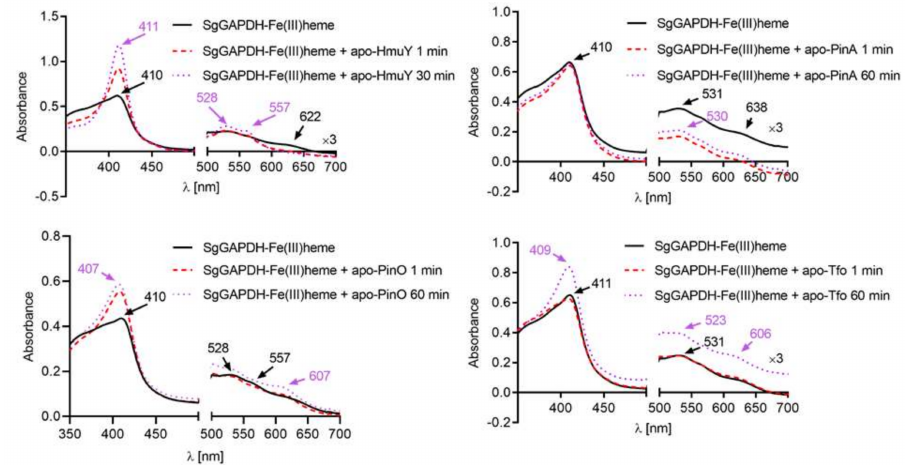
Figure 5. Heme sequestration by HmuY and its homologs from SgGAPDH-heme complex under oxidizing conditions. SgGAPDH-heme complex (10 µ M) was incubated under air (oxidizing) conditions with equimolar concentration of HmuY, PinO, PinA or Tfo apo-proteins. Changes in absorption spectra analyzed by UV-visible spectroscopy are shown at indicated time points.